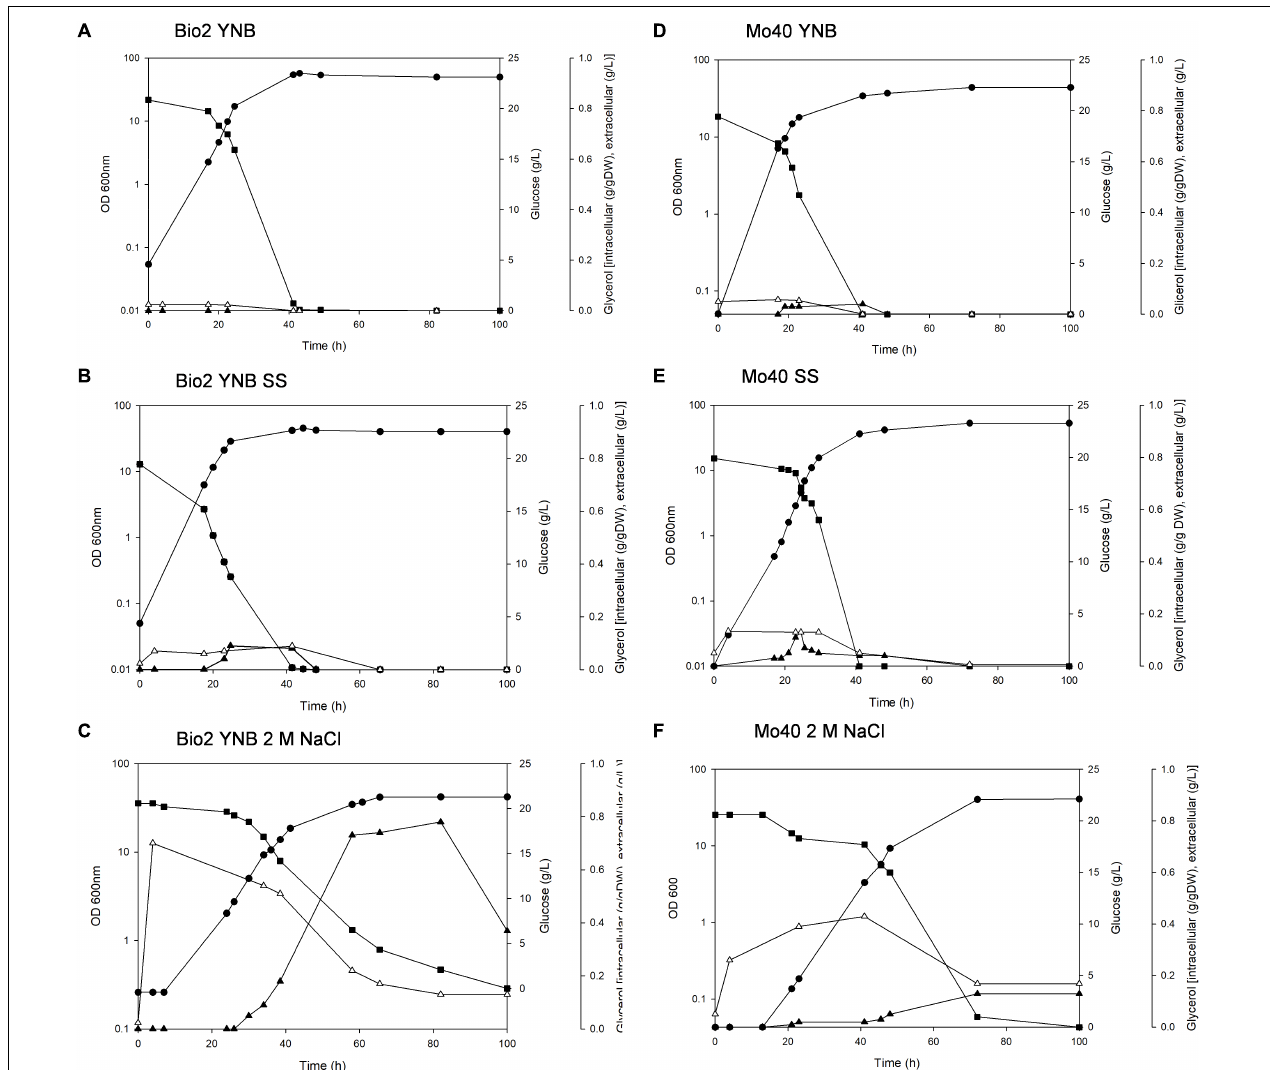
FIGURE 1 | Growth of Debaryomyces hansenii Bio2 and Mo40 strains under different conditions. (A,D) Growth on YNB, control condition; (B,E) growth in presence of sea salts (SS); (C,F) growth in presence of 2 M NaCl. OD 600 nm, (cid:4) glucose (g/l), (cid:78) extracellular glycerol (g/l), (cid:49) intracellular glycerol (g/g of dry weight). Broth cultures were performed in triplicate and standard deviations were lower than 5%. (cid:32)